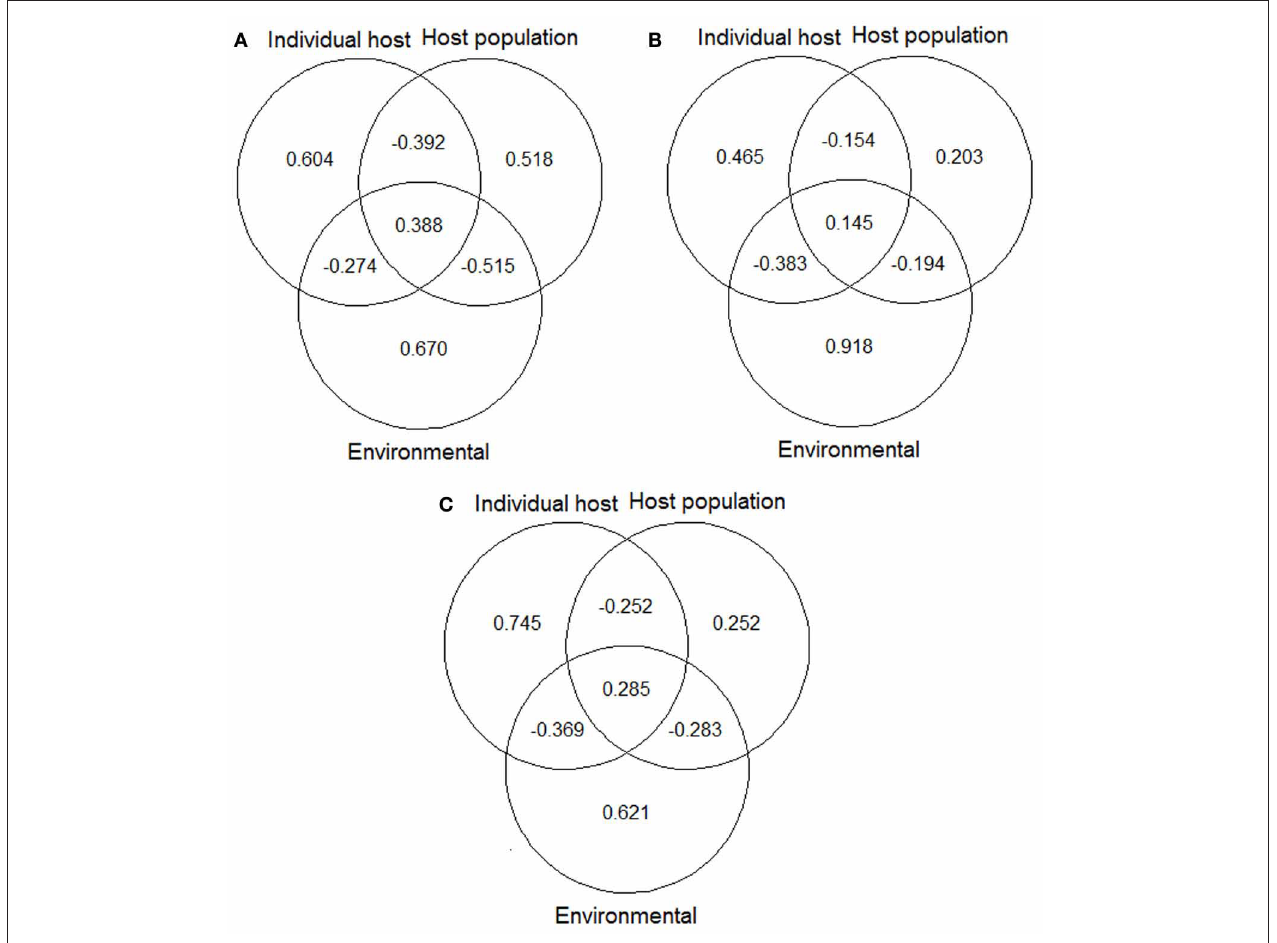
FIGURE 1 | Variation partitioning of the deviance explained by final models: (A) model for red deer males; (B) model for hinds; and (C) model for males and hinds. Values shown in the diagrams are the proportions of variation of each final model that can be explained exclusively